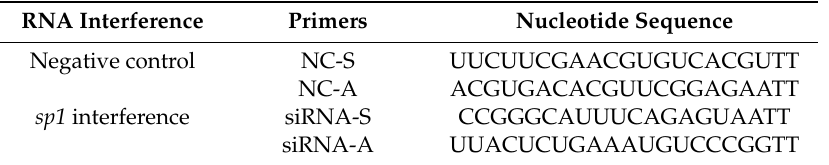
Table 6. RNAi nucleotide sequence used in this study.